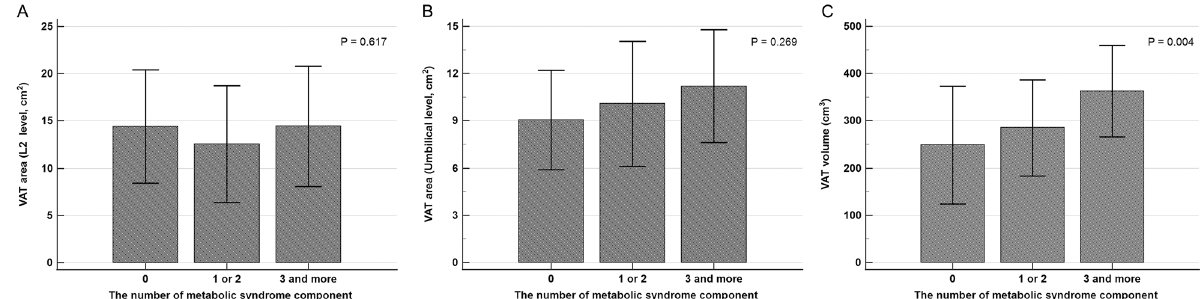
Figure 1. The difference in abdominal visceral adiposity according to the number of metabolic syndrome component. ( A ) Visceral adipose tissue (VAT) area at the level of L2 did not have difference according to the number of metabolic syndrome component. ( B ) VAT area at the level of umbilicus had increasing trend with increasing corresponding number of metabolic syndrome component without statistical significance. ( C ) VAT volume has significantly higher value according to the increasing corresponding number of metabolic syndrome component.